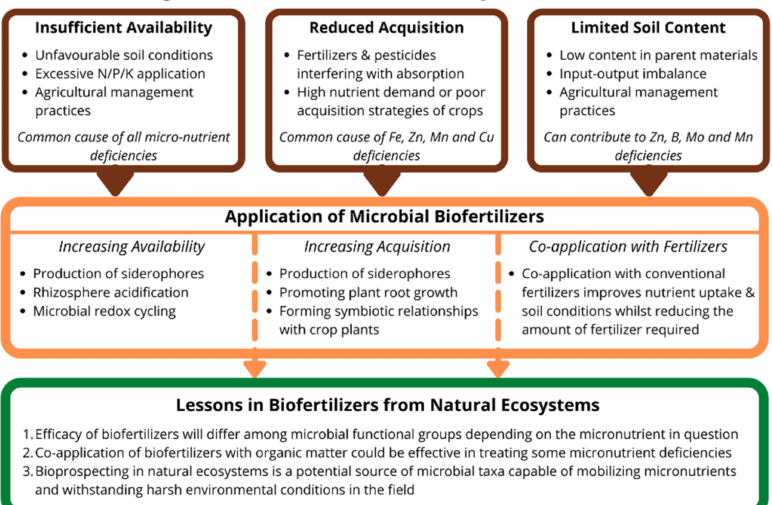
Figure 2. Conceptual diagram showing the main causes of micronutrient limitation, strategies for alleviating micronutrient deficiencies using microbial biofertilizers, and research considerations for future research into biofertilizers, based on observations from natural